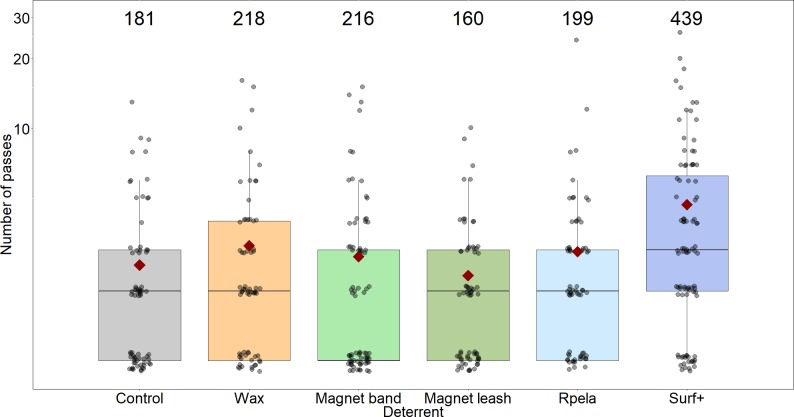
Number of passes trial−1 shark−1 during 15-minute trials (grey circles; with small ‘jittering’ to improve readability).Median values are indicated by the horizontal bar; length of the box is the inter-quartile range; whiskers represent quartiles; circles are data; and red diamond is the mean. Y-axis shown on the log10 scale. Grey, control; orange, Chillax Wax; light green, magnet band; green, magnet leash; light blue, Rpela; blue, Shark Shield (Ocean Guardian) Freedom+ Surf. Numbers indicate total number of passes.